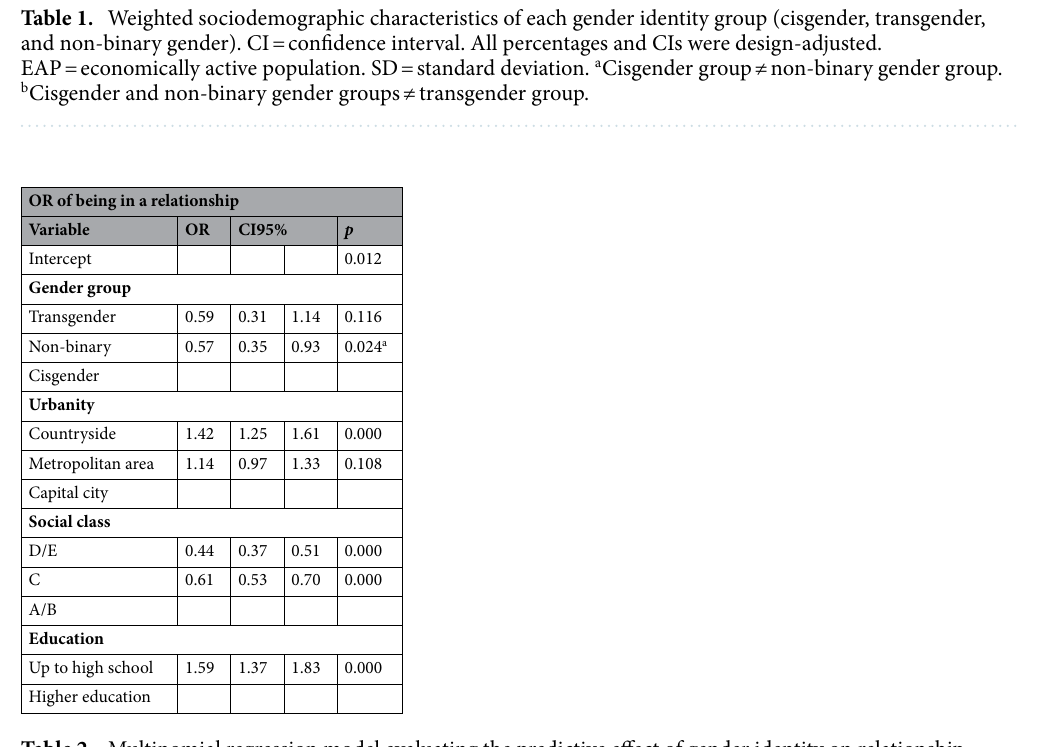
Table 2. Multinomial regression model evaluating the predictive effect of gender identity on relationship status. OR = odds ratio; CI = confidence interval. a Non-binary gender group ≠ cisgender